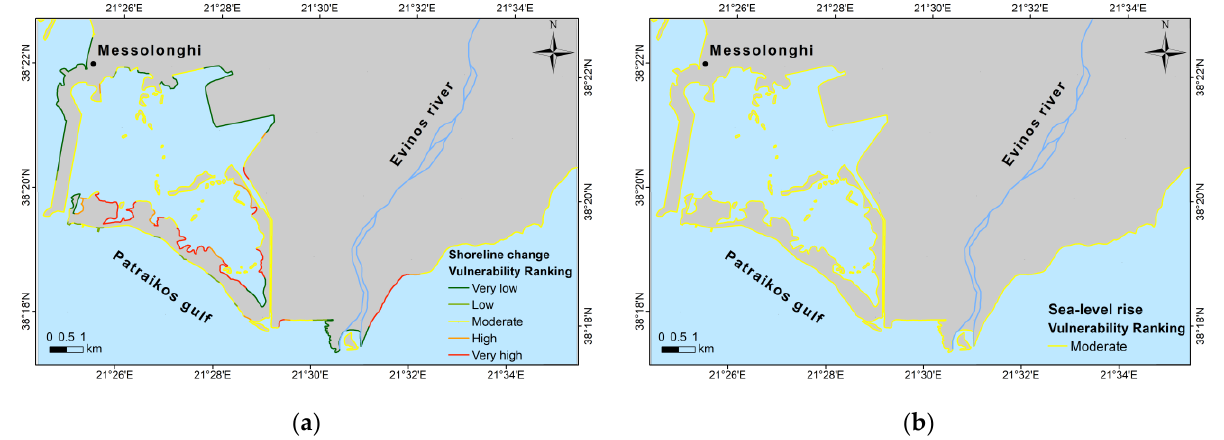
Figure 3. Vulnerability ranking maps based on ( a ) diachronic shoreline change and ( b ) relative sea-level change.